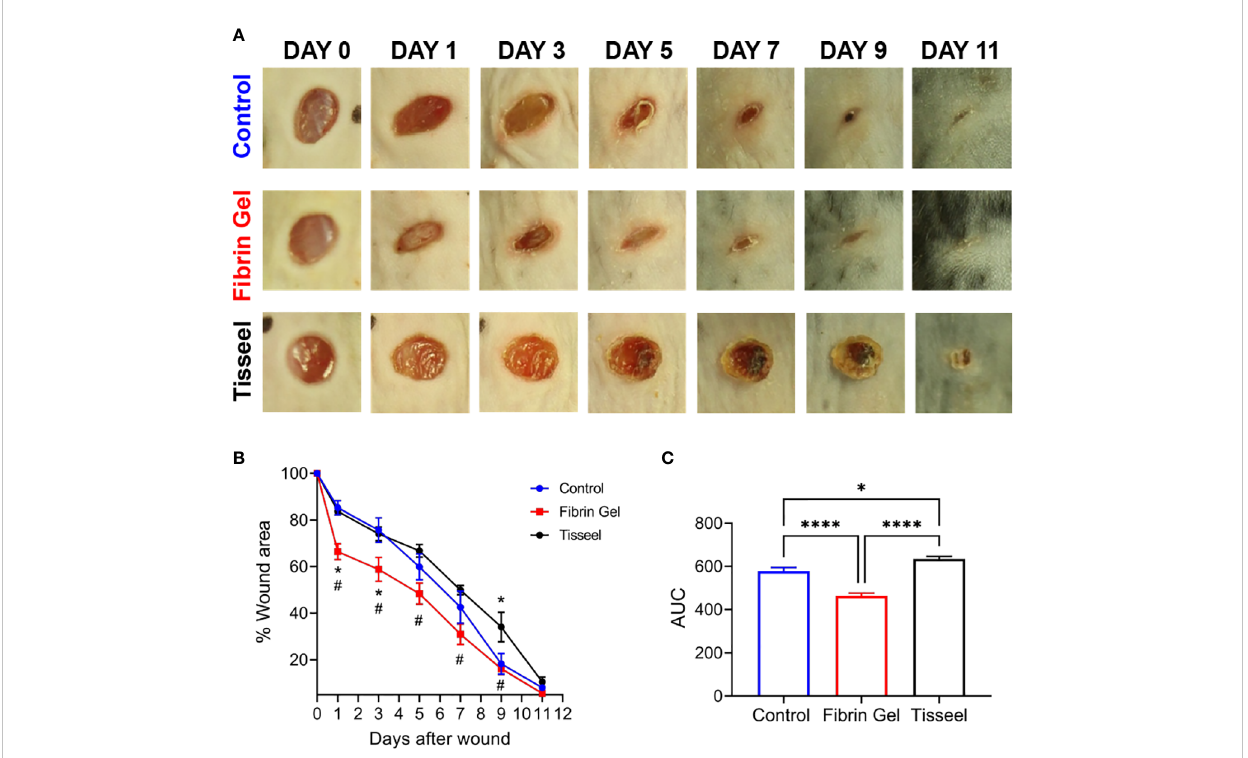
FIGURE 5 Effect of fi brin hydrogel and Tisseel on mouse skin wound healing. Repair of wounds treated with fi brin hydrogel (Fibrin Gel), fi brin sealant Tisseel or left untreated (Control). (A) Representative digital images of wounds up to 11 days after wounding. (B) Wound healing expressed as percentage of wound area compared to day 0. n ≥ 5 mice per group, *p<0.05 vs Control group, #p<0.05 Fibrin Gel vs Tisseel group. (C) Wound healing expressed as area under the curve. *p<0.05, ****p<0.0001. Data are shown as mean ±